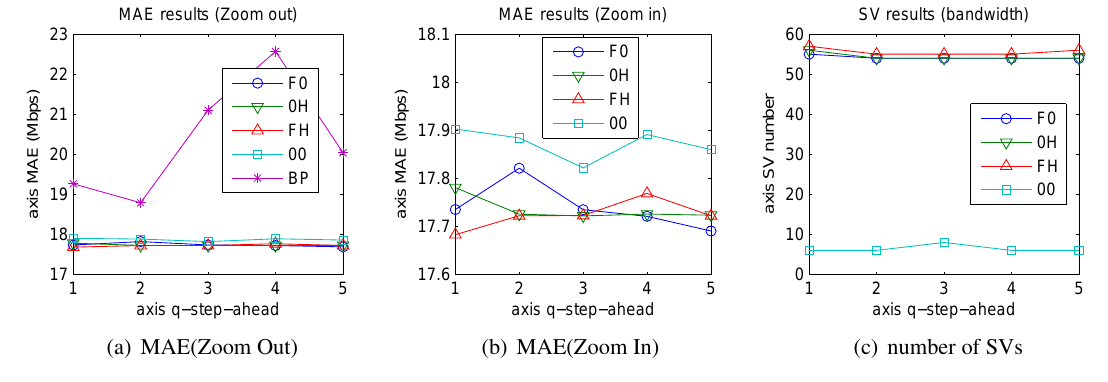
Figure 7: prediction